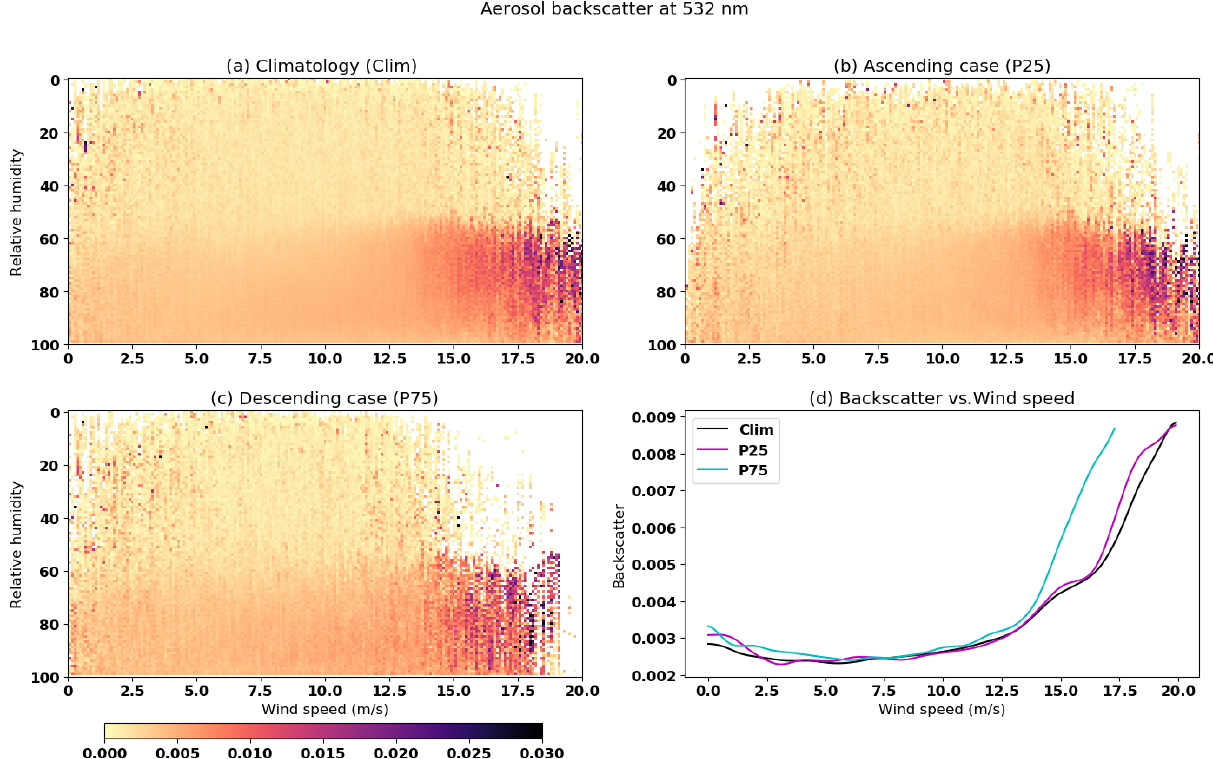
Figure 1. Total backscatter coefficient at 532nm (km − 1 sr − 1 ) as a function of surface wind speed and relative humidity. (a) Climatological conditions (Clim), all aerosol profiles included, (b) ascending case, only when 700hPa geopotential height is less than the 25th percentile (P25) and (c) descending case, only when 700hPa geopotential height is greater than the 75th percentile (P75). (d) Expressed only as a function of wind speed (averaged over all relative